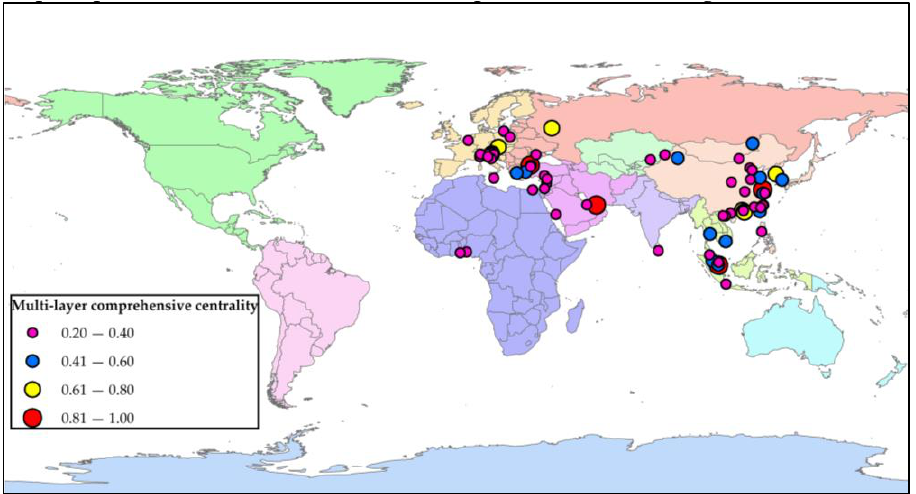
Figure 7. Geographical distribution of important node